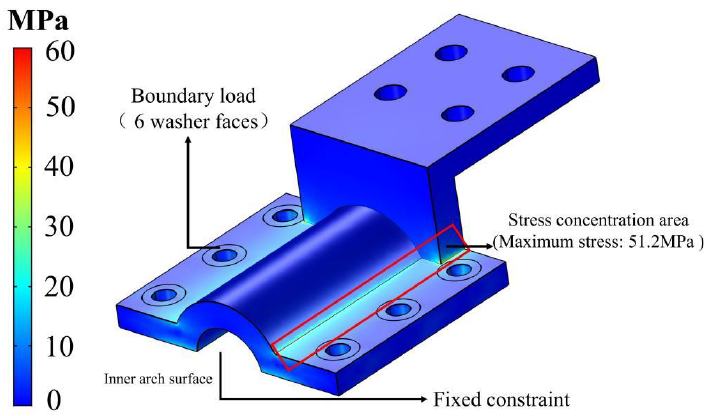
Figure 6. Simulated stress distribution of the clamp.